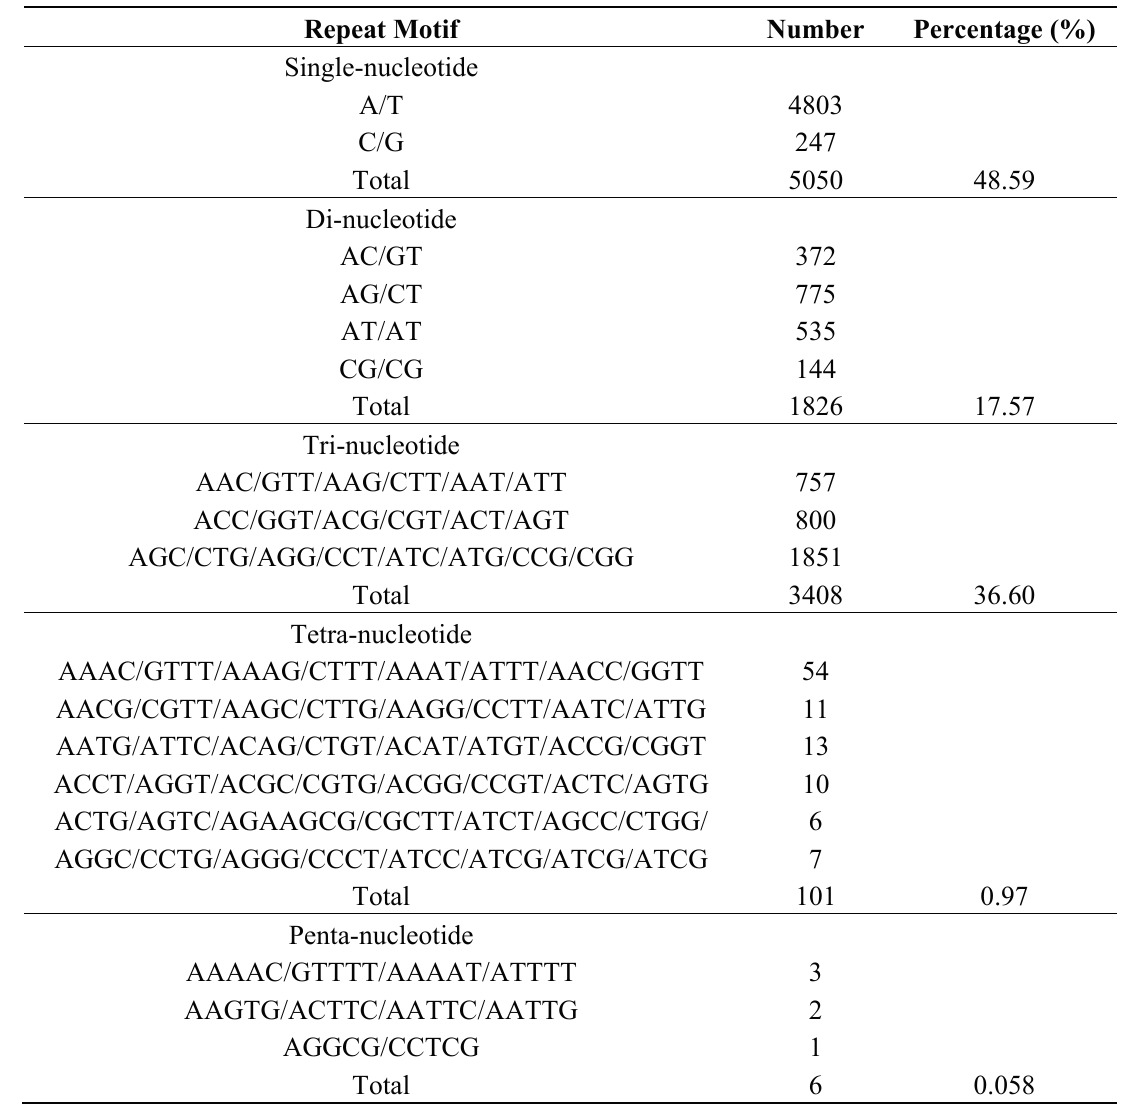
Table 2. Summary of simple sequence repeat (SSR) types in the C. medinalis